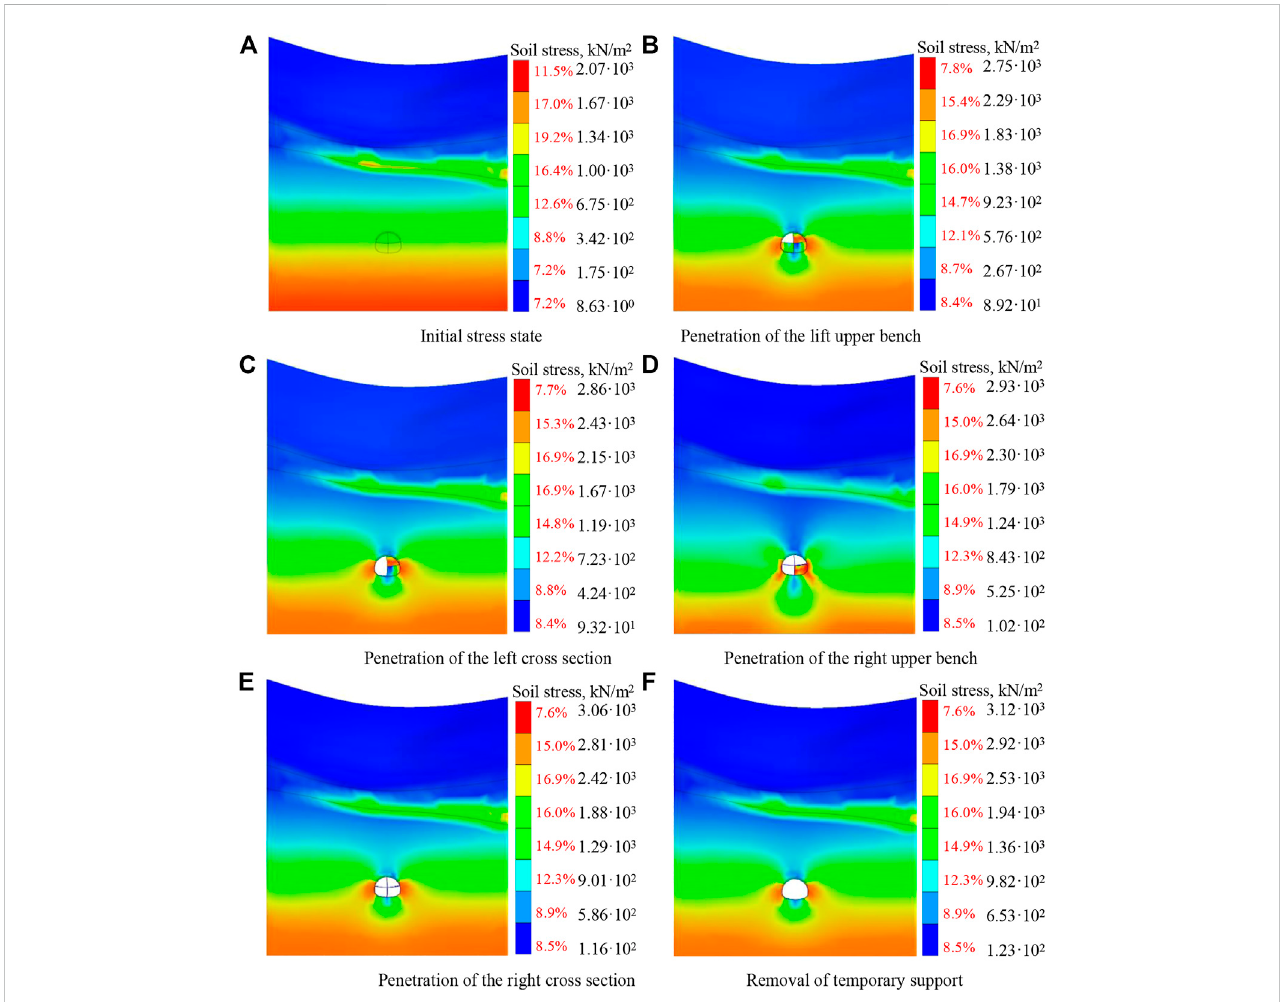
FIGURE 8 Stress of tunnel surrounding rock under CD method construction. (A) Initial stress state (B) Penetration of the lift upper bench. (C) Penetration of the left cross section (D) Penetration of the right upper bench. (E) Penetration of the right cross section (F) Removal of temporary support.